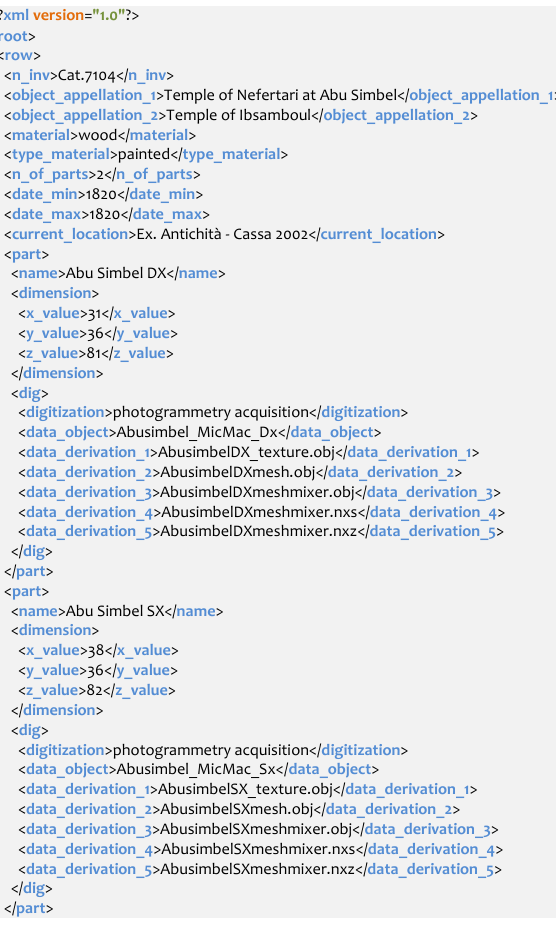
Figure 4. XML about data of the Nefertari Temple in Abu